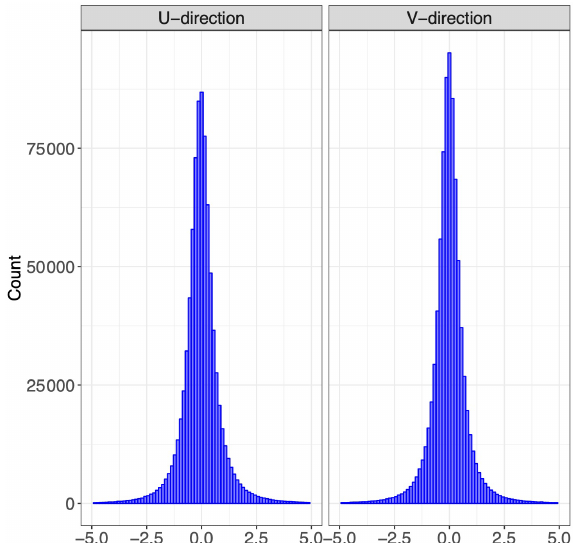
Figure 17. U and v winds normalized using the error characteristics developed by our